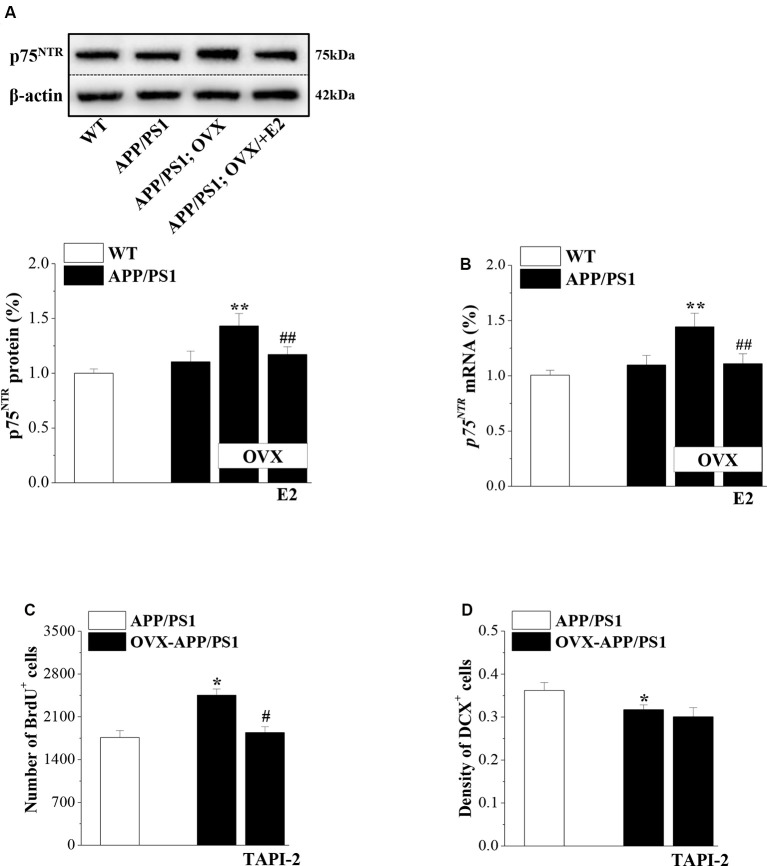
p75NTR participates in E2-induced protection of NSC proliferation in APP/PS1 mice. (A,B) Influence of E2 on the level of p75NTR in 6-month-old APP/PS1 mice. The upper panels represent representative blots of p75NTR. Bar graphs show the level of p75NTR protein or p75NTR mRNA in APP/PS1 mice or OVX-APP/PS1 mice treated with vehicle or E2 for 2 months. **P < 0.01 vs. sham-op APP/PS1 mice; ##P < 0.01 vs. OVX-APP/PS1 mice (two-way ANOVA). (C,D) Influence of the p75NTR inhibitor TAPI-2 on the excessive proliferation of NSCs and survival of immature neurons in the DG of 6-month-old APP/PS1 mice. The bar graphs show the number of BrdU+ cells and the density of DCX+ cells in APP/PS1 mice or OVX-APP/PS1 mice treated with vehicle or TAPI-2 for 7 days. *P < 0.05 vs. sham-op APP/PS1 mice; #P < 0.05 vs. OVX-APP/PS1 mice (two-way ANOVA).